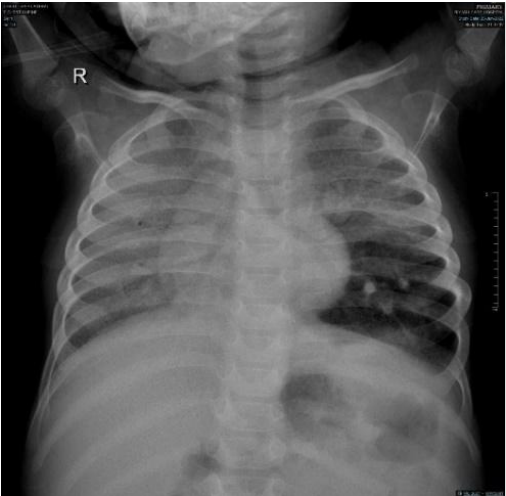
Figure 2. Chest X-ray anteroposterior film shows a diffuse right lung and left upper lobe ground glass opacity with retrocardiac collapse and hyperinflation of the left lower lobe but no oligemia. The mesocardium is explained by the mild rotation to the right side.